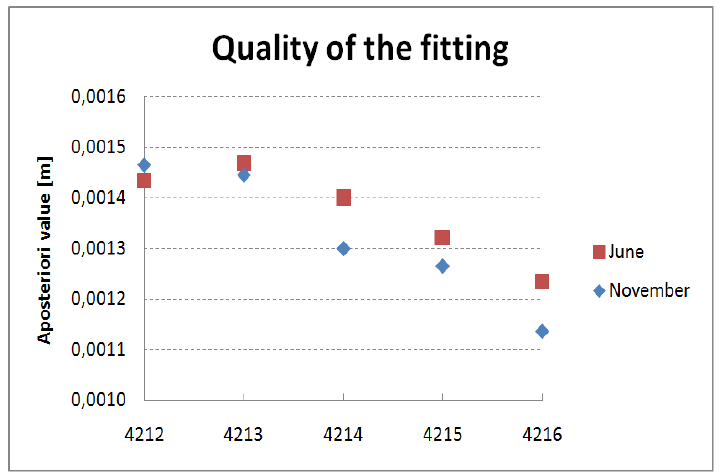
Figure 7. A posteriori values of cylinder